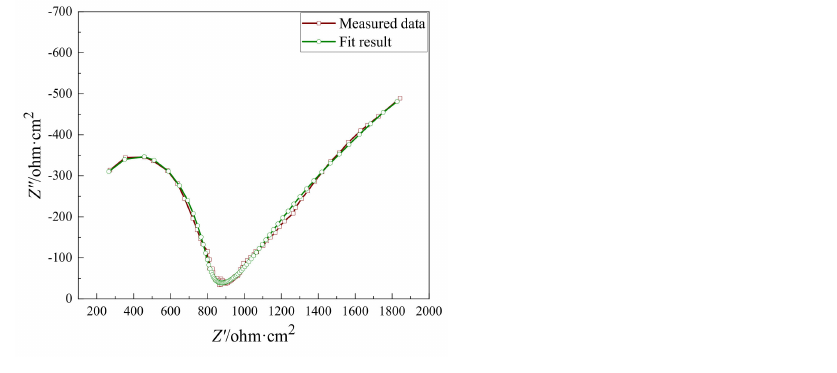
Figure 10. Fitting curve for the equivalent circuit of 60Si2Mn-B of the rusty sample. Table 4. Values of the equivalent circuit fitting data of 60Si2Mn-B, the rusty sample. Element Value